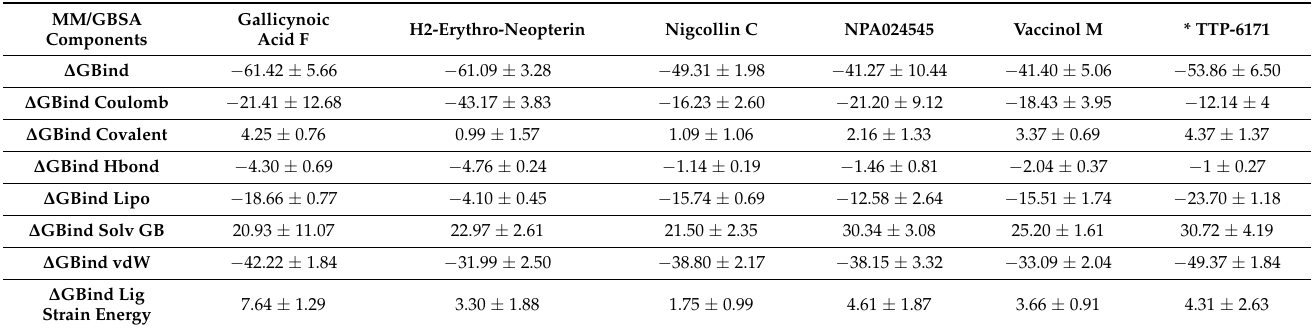
Table 3. Total Molecular Mechanics Generalized Born Surface Area (MM/GBSA) binding free energy (kcal/mol) values computed for the MPXV docked with top five screened compound complexes. * reference native ligand molecule.